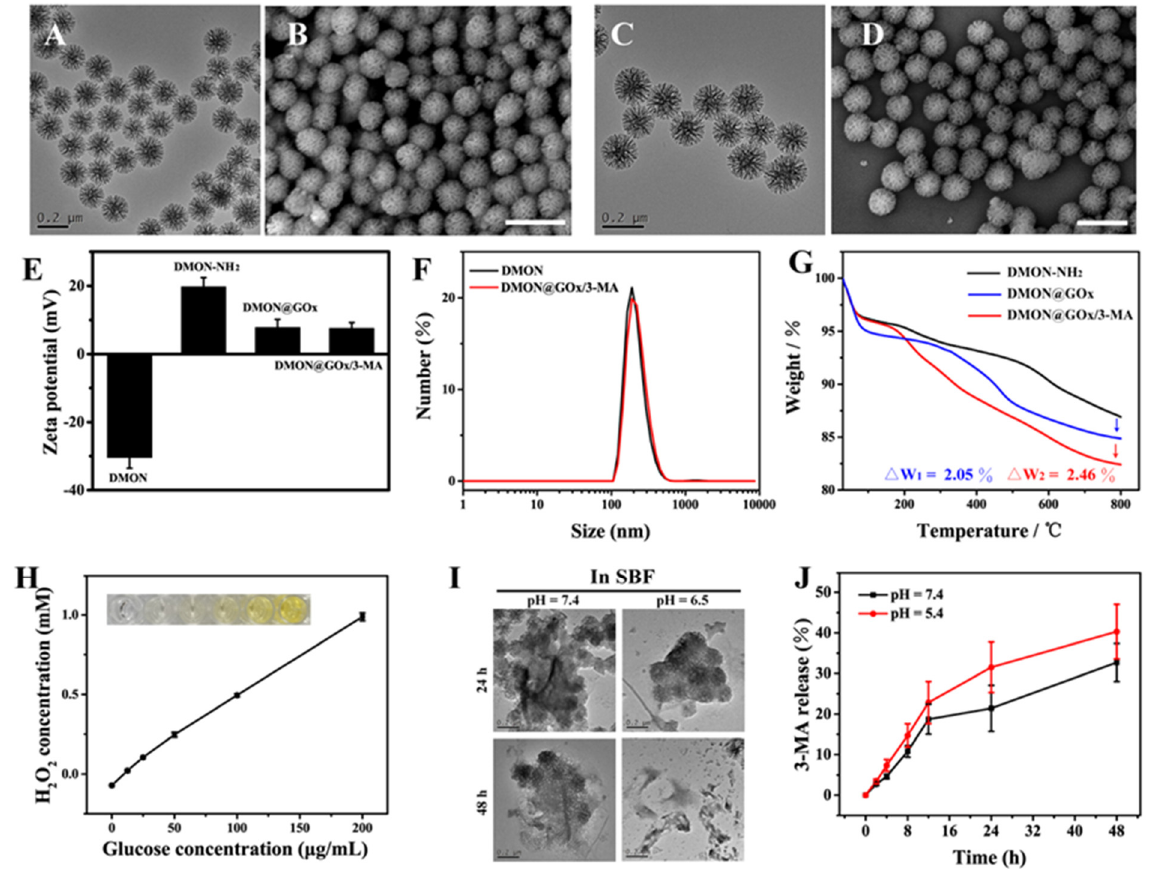
Figure 2. Characterization of DMON@GOx/3-MA nanoparticles. Transmission electron microscopy (TEM) ( A ) and scanning electron microscopy (SEM) ( B ) images of DMON nanoparticles (scale bar = 200 nm). TEM ( C ) and SEM ( D ) images of DMON@GOx/3-MA nanoparticles (scale bar = 200 nm). ( E ) Zeta potential of different nanoparticles during the synthetic process (n = 3, mean ± s.d.). ( F ) Dynamic light scattering (DLS) data of DMON and DMON@GOx/3-MA nanoparticles in deionized water. ( G ) Thermogravimetric (TG) curves of DMON-NH 2 , DMON@GOx, and DMON@GOx/3-MA nanoparti- cles. The arrows indicate the decrease of weight. ( H ) The generated H 2 O 2 concentration after co-incubation DMON/GOx nanoparticles at different concentrations of glucose for 2 h (n = 3, mean ± s.d.). ( I ) TEM images of DMON@GOx/3-MA nanoparticles after dispersed in different simulated body fluid (SBF) buffer (pH = 7.4 and 5.4) for 24 and 48 h (Scale bar = 200 nm). ( J ) Release kinetics of 3-MA from DMON@GOx/3-MA (n = 3, mean ± s.d.).